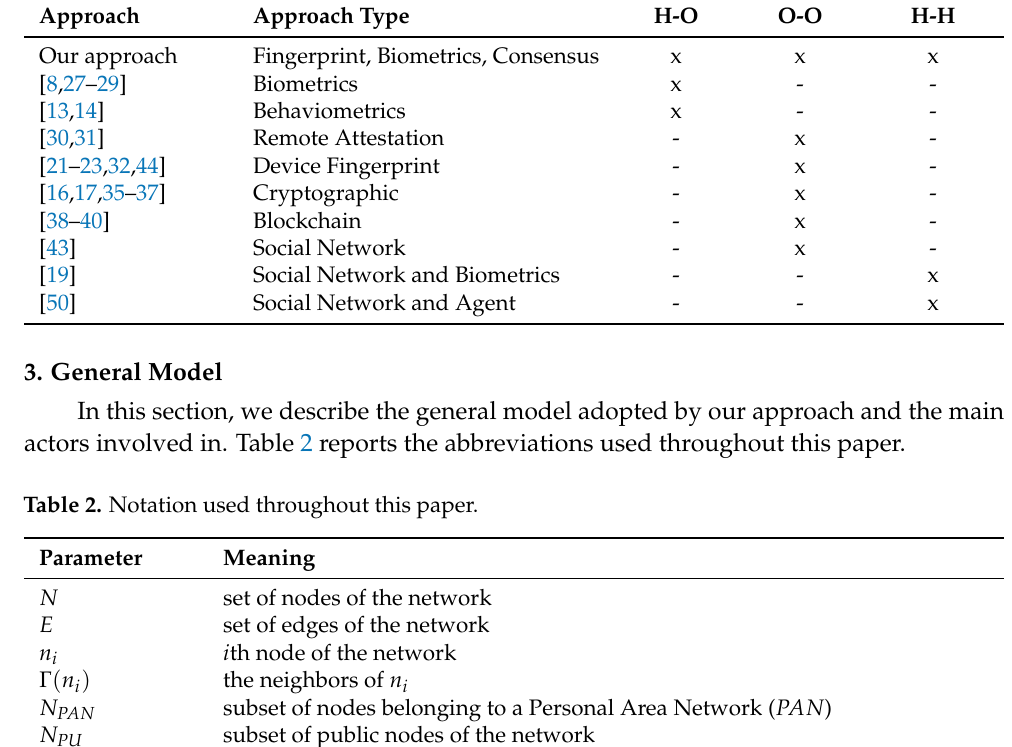
Table 1. Comparison of our approach with related ones. Approach